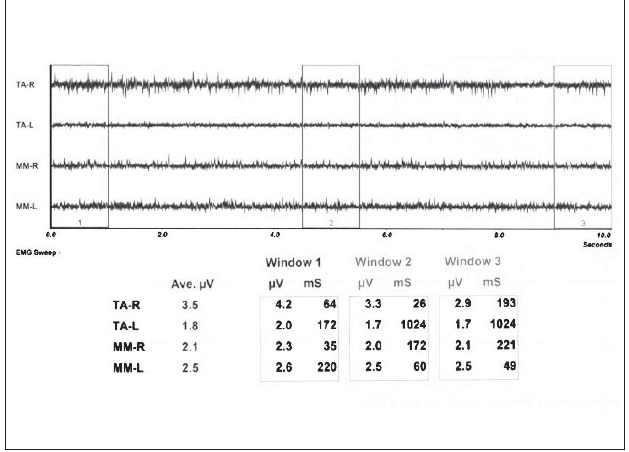
Fig. 1. EMG tracings obtained acquisition values before the application of the LLLT for right and left temporal muscles (TA-R and TA-L, respectively) and for right and left masseter muscles (MM-R and MM-L, respectively) before LLLT.